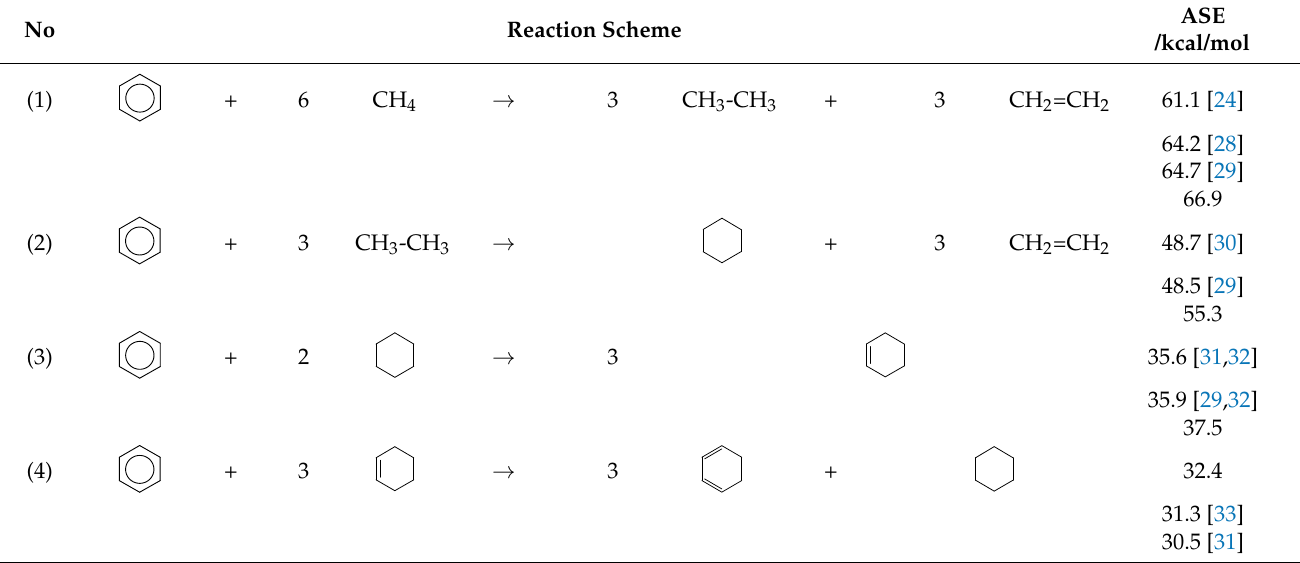
Table 1. Examples of aromatic stabilization energies (ASE) for benzene obtained experimentally and